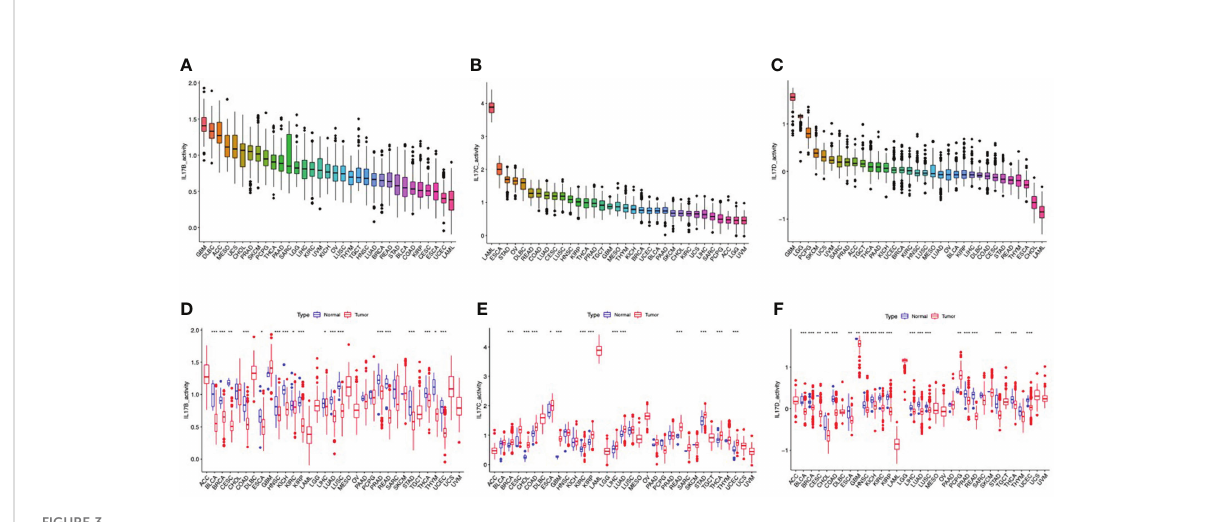
FIGURE 3 The different activity analyses based on the TCGA dataset. (A – C) The mean activity of IL-17B, IL-17C, and IL-17D in 33 cancers (from high to low). (D – F) The different activity analysis between tumors and normal groups of IL-17B, IL-17C, and IL-17D in 33 cancers (from high to low). ( ∗∗∗∗ p < 0.0001; ∗∗∗ p < 0.001; ∗∗ p < 0:01; ∗ p <